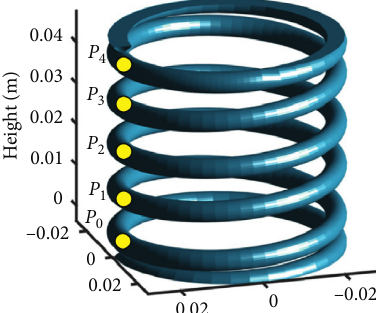
Figure 11: Model of the designed spring.